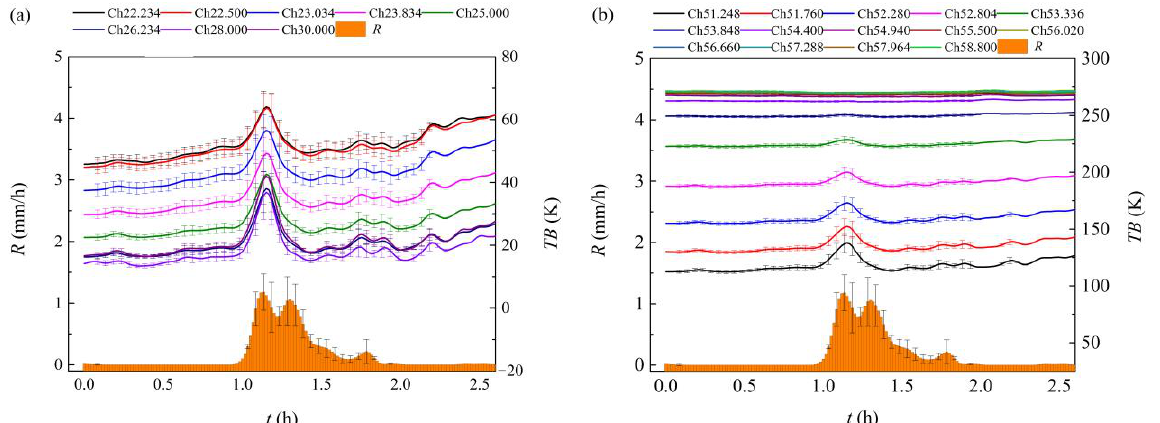
Figure 9. Temporal evolution of brightness temperatures at the sampling channel from 22.2 GHz to 60.0 GHz for snowy days. ( a ) 22.2 – 30.0 GHz and ( b ) 51.24 – 58.8 GHz.